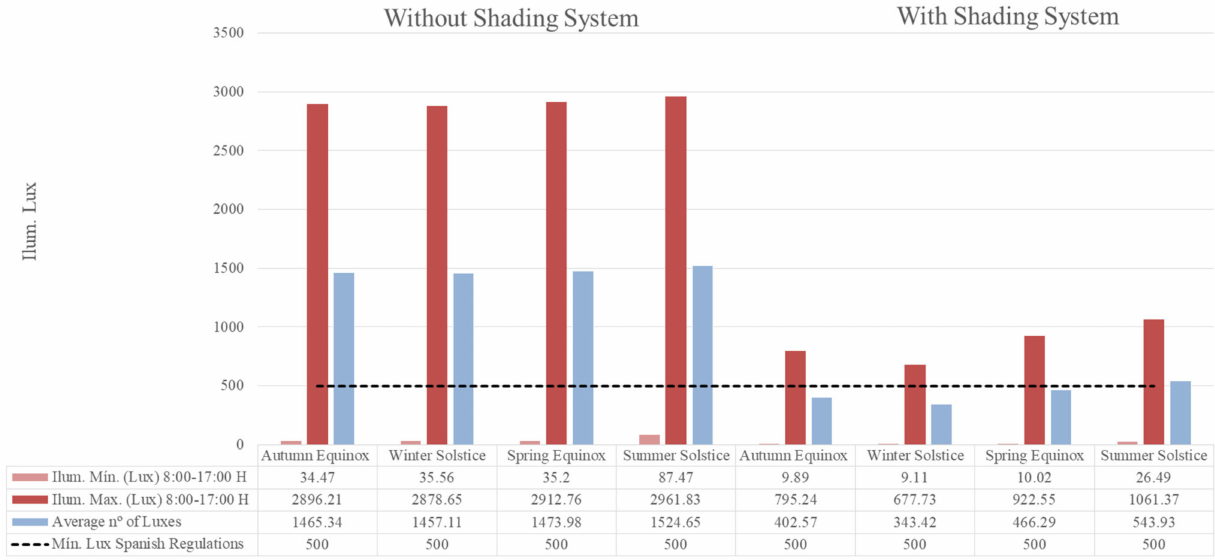
Figure 21. Illuminance caused by daylight: classroom level 01. DesignBuilder simulations results. With and without shading